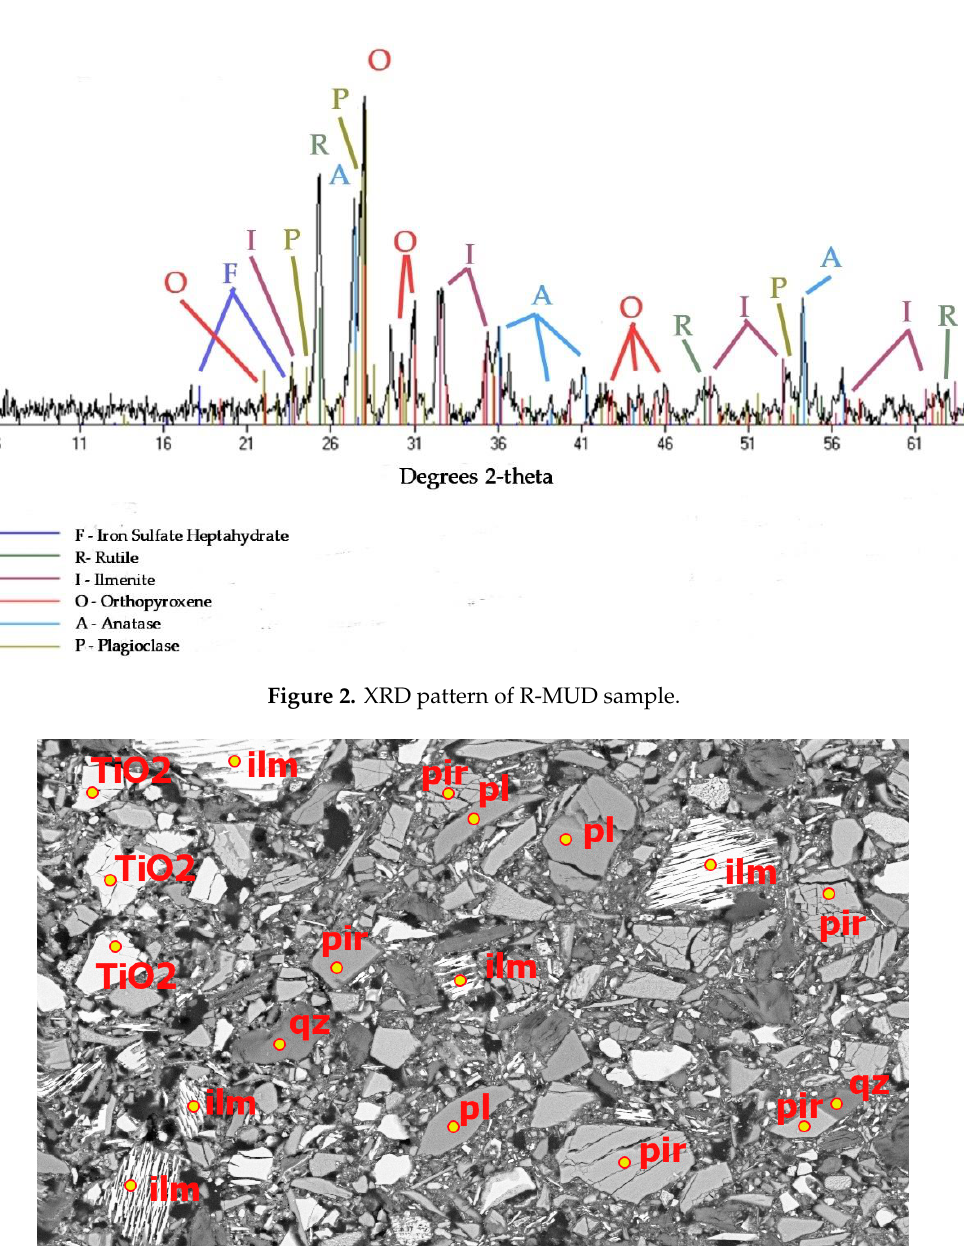
Figure 3. Backscattered electron (BSE) image of R-MUD sample (backscattered electron mode).